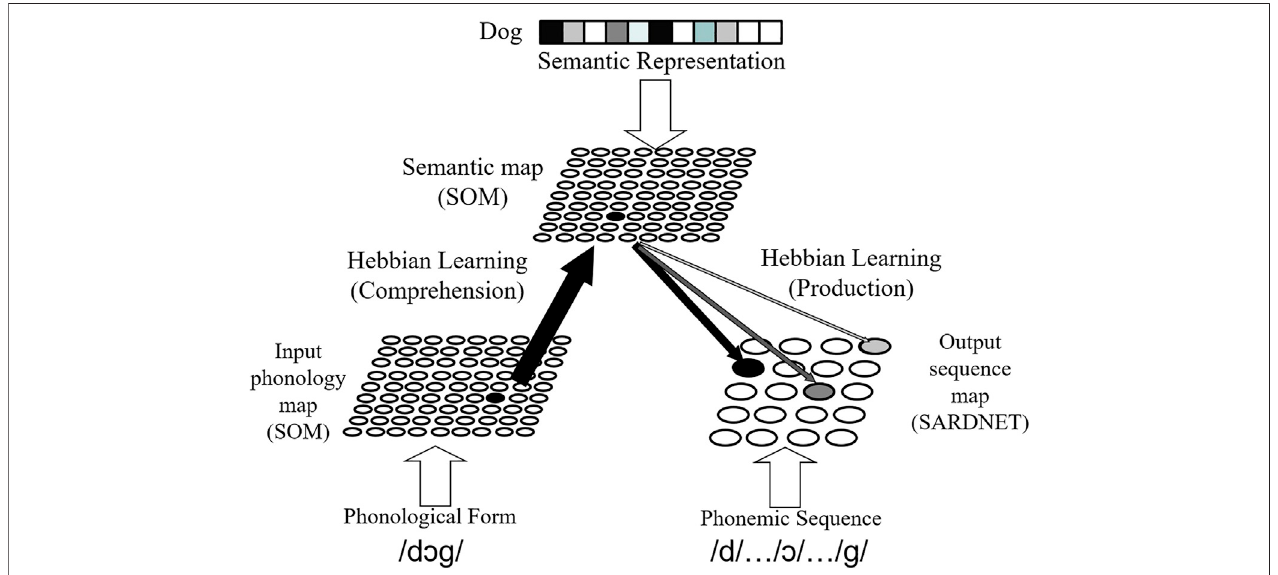
FIGURE 1 | The architecture of the DevLex-II